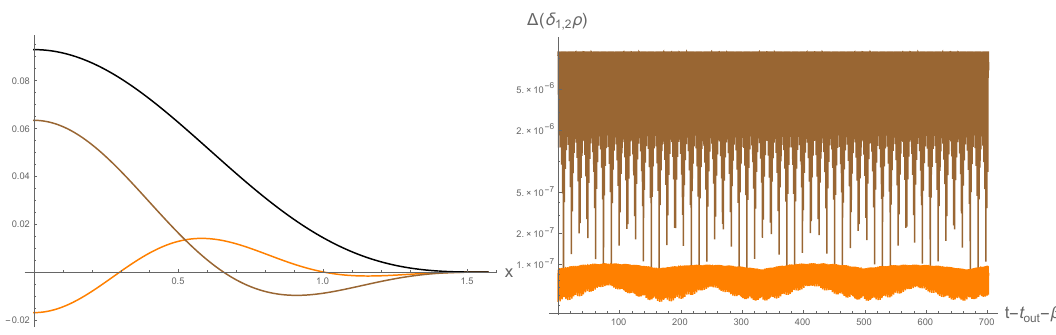
Figure 24 . Left: (cid:26) (black), 10 3 (cid:14) 1 (cid:26) (brown) and 10 5 (cid:14) 2 (cid:26) (orange) for (cid:12) out = 5000 at a time t = 600 after the quench-out. The three magnitudes clearly display the hierarchy described in the main text. Right: (cid:1)( (cid:14) 1 (cid:26) ) (brown) and (cid:1)( (cid:14) 2 (cid:26) ) (orange) during the whole post-quench-out regime for (cid:12) out = 5000. We clearly see that the inequality (cid:1)( (cid:14) 2 (cid:26) ) (cid:28) (cid:1)( (cid:14) 1 (cid:26) ) holds. scales (cid:12) = 1000 ; 2000 ; 3000 ; 4000 ; 5000. In each one of them, the post quench value out